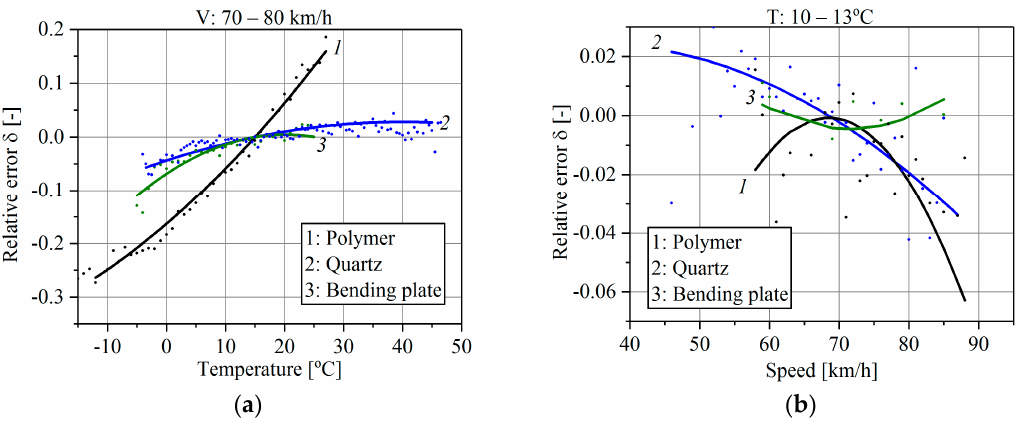
Figure 4. ( a ) Temperature characteristics; ( b ) Speed characteristics of polymer, quartz and bending plate sensors installed in the pavement.